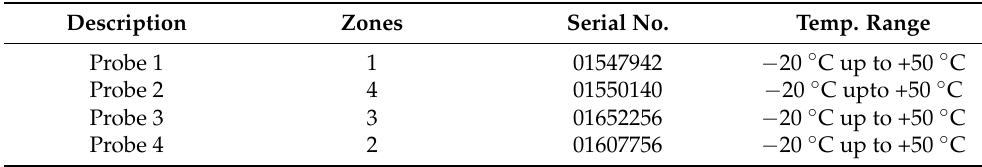
Table 1. Zonewise probe specification.